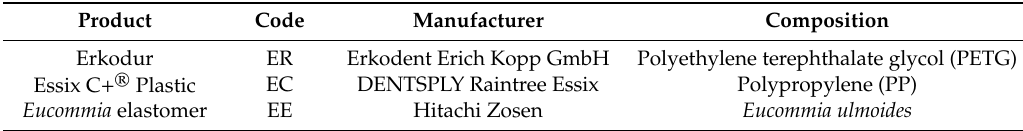
Table 1. Orthodontic thermoplastic materials used in this